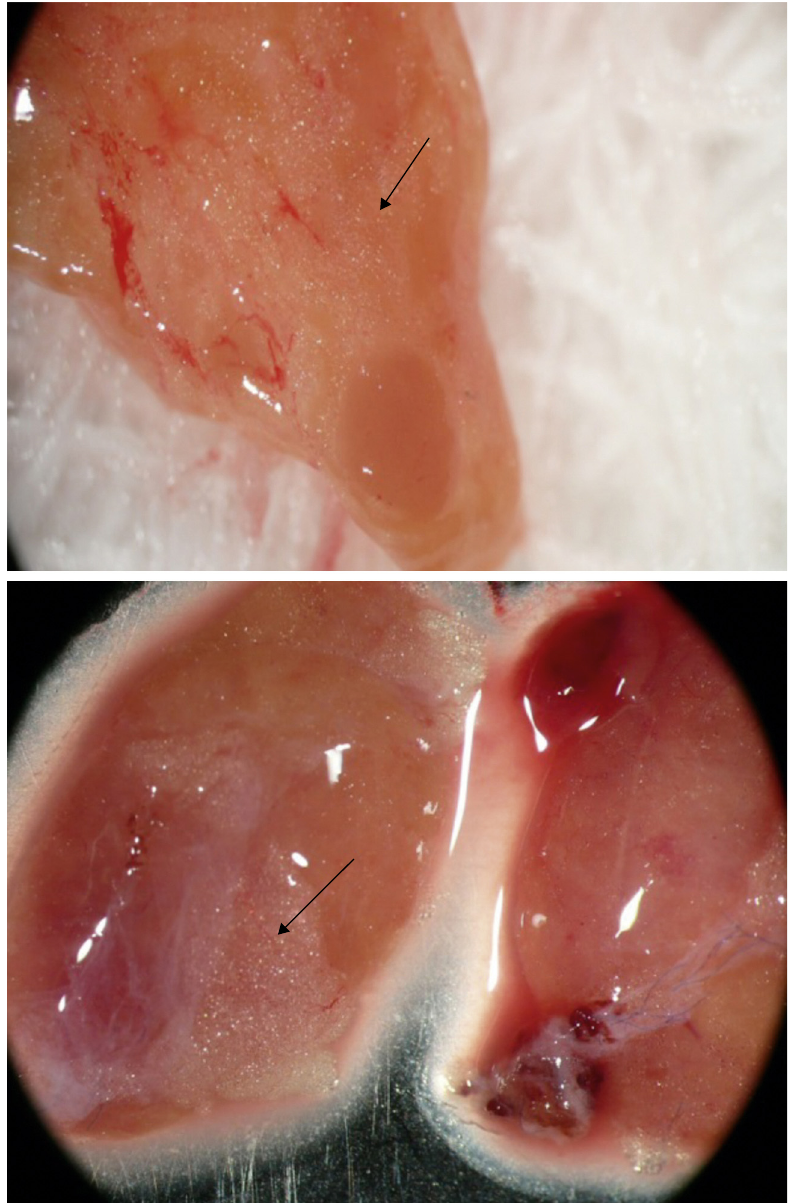
Figure 2 Stromal fat cells (arrows) in resected parathyroid